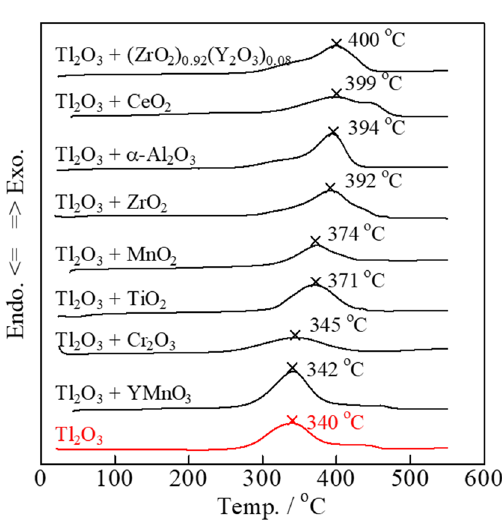
Figure 5. DSC curves of carbon black (2 wt%) mixed with the various Tl 2 O 3 ‒ 80 wt% added oxide composite